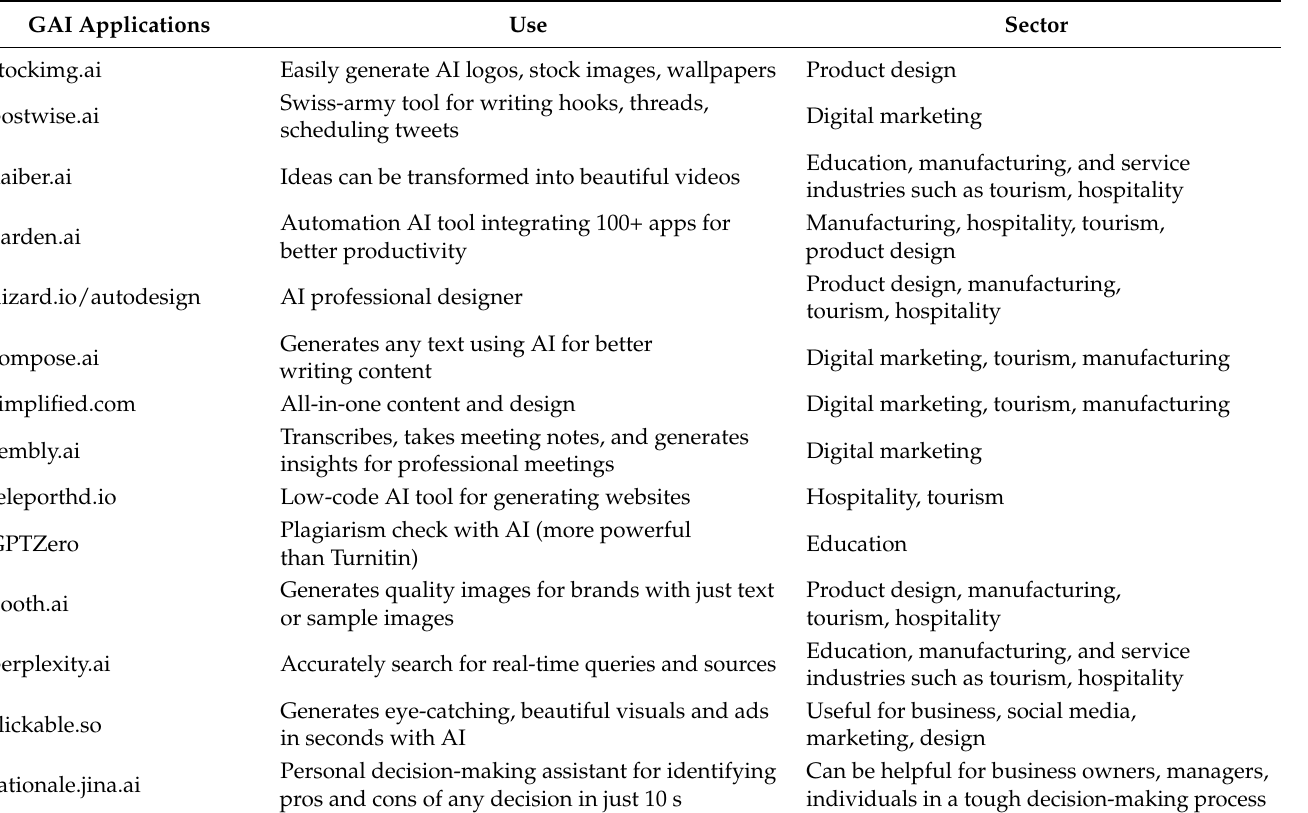
Table 1. GAI tools for different business